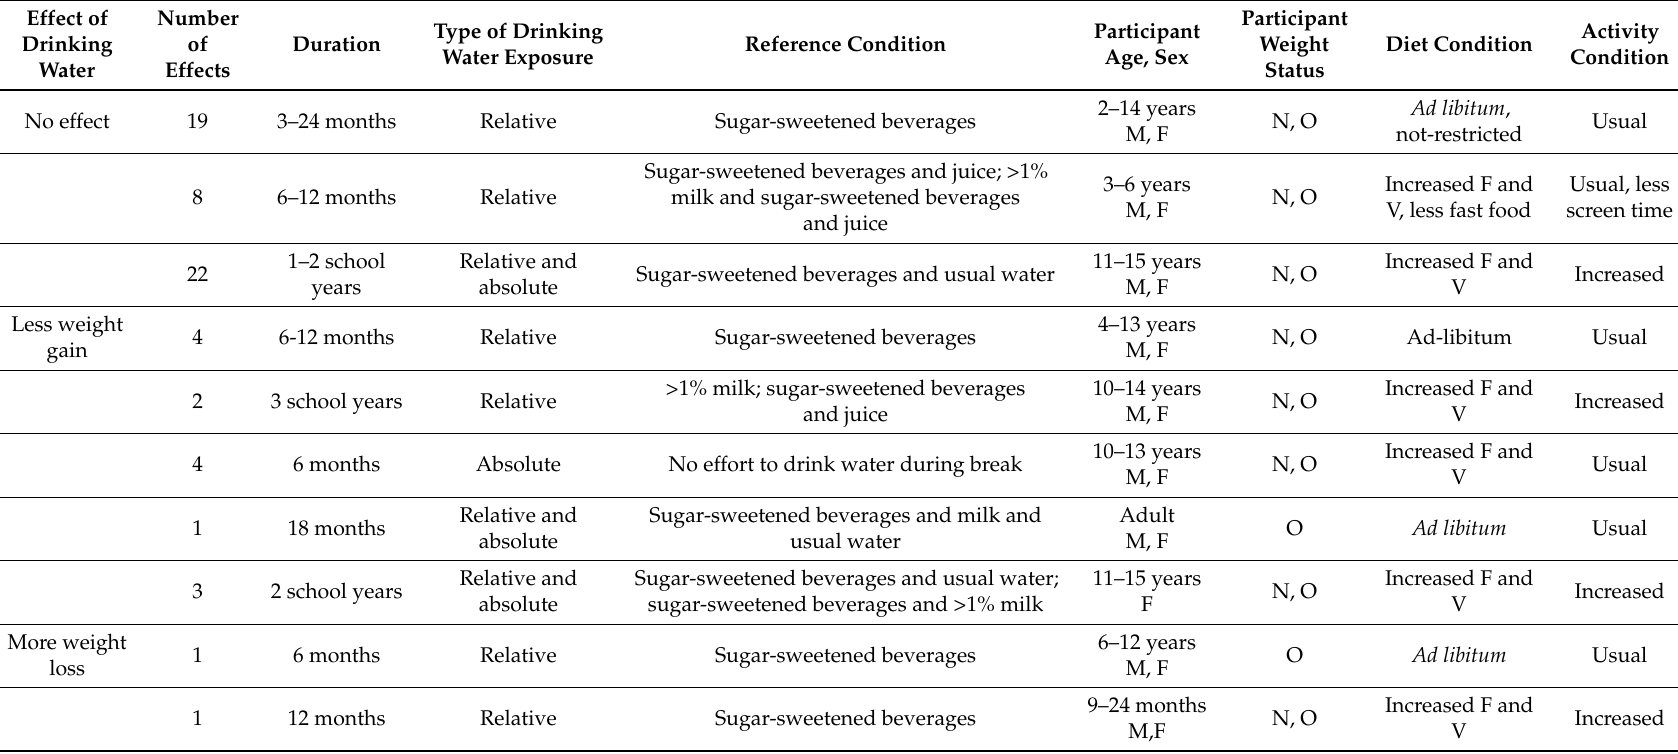
Table 6. Multiple component RCT conditions associated with negative, null and positive effects of plain drinking water on weight